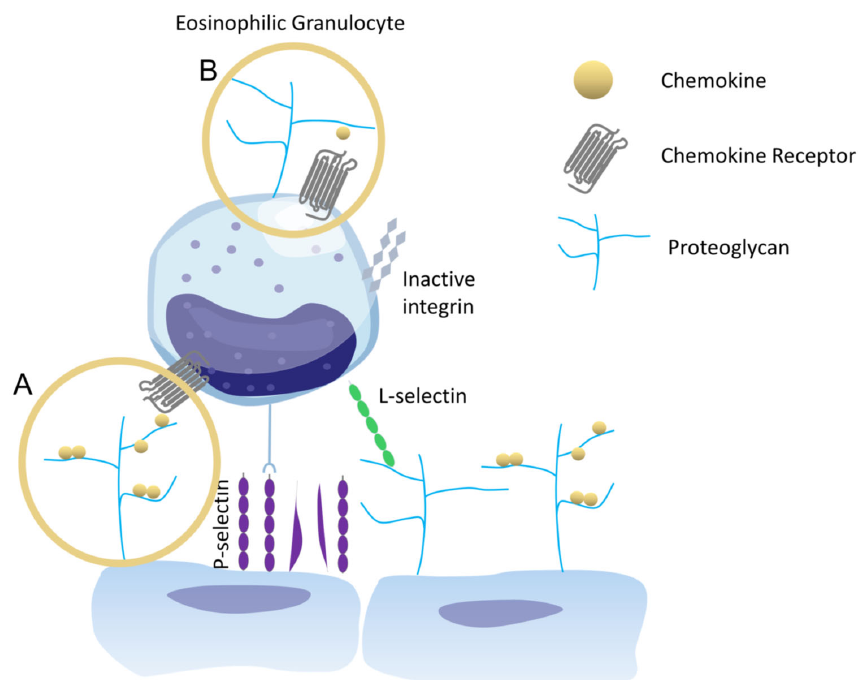
Figure 2 . Proteoglycans (PGs) located on the endothelium ( A ), postulated as “trans” activity, and Figure 2. Proteoglycans (PGs) located on the endothelium ( A ), postulated as “ trans ” activity, and PGs PGs located on the surface of eosinophils ( B ), postulated as “cis” activity of GAGs/PGs—with re ‐ located on the surface of eosinophils ( B ), postulated as “ cis ” activity of GAGs/PGs—with respect to spect to with G ‐ protein coupled chemokine receptors on the immune cell—orchestrate the migra ‐ with G-protein coupled chemokine receptors on the immune cell—orchestrate the migration of these tion of these cells to inflammatory sites . cells to inflammatory